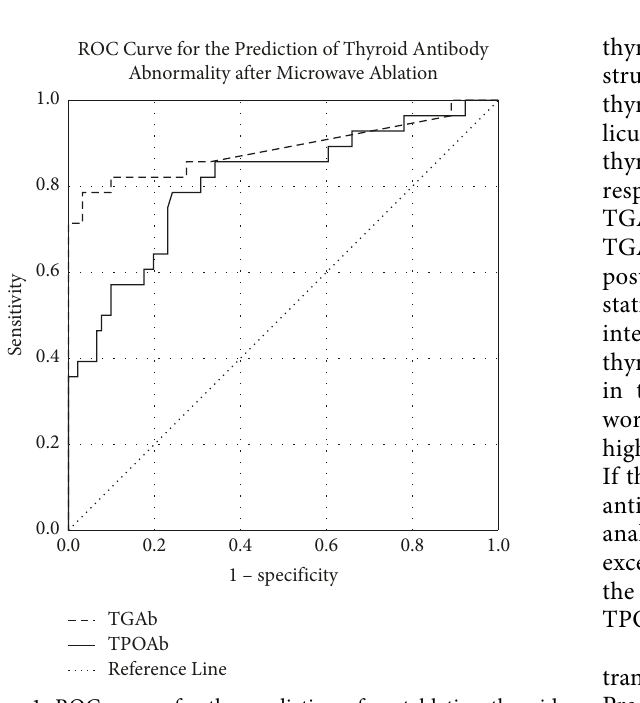
Figure 1: ROC curves for the prediction of postablation thyroid antibody abnormalities by thyroid peroxidase (TPOAb) and thy- roglobulin (TGAb).